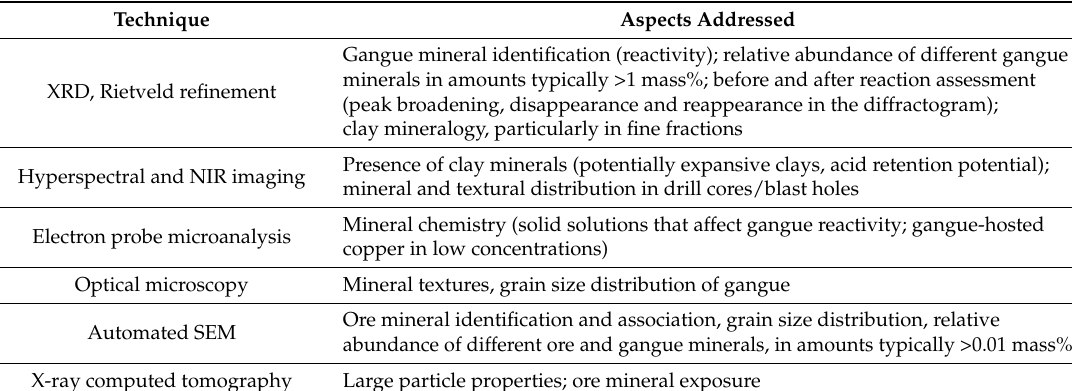
Table 5. Mineralogical techniques for ore characterisation with regard to heap leaching.